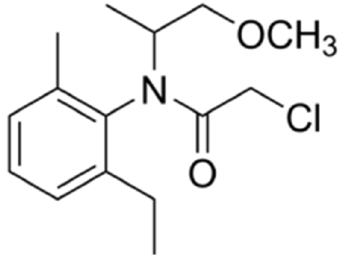
Figure 1. Structural formula of S-metolachlor [27].